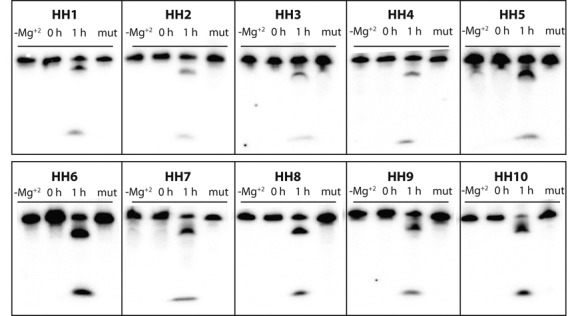
Summary of designed hammerhead cleavage. Each designed hammerhead RNA was incubated under mild conditions for 1 h as described in the ‘Materials and Methods’ section to assess cleavage. As negative controls, a no magnesium and a 0-h reaction were also conducted for each RNA. Additionally, the 8G mutation, predicted to be incompatible with the hammerhead structure (see ‘Materials and Methods’ section), was constructed for each designed sequence and examined under equivalent conditions to confirm that self-cleavage occurs using the expected hammerhead mechanism.